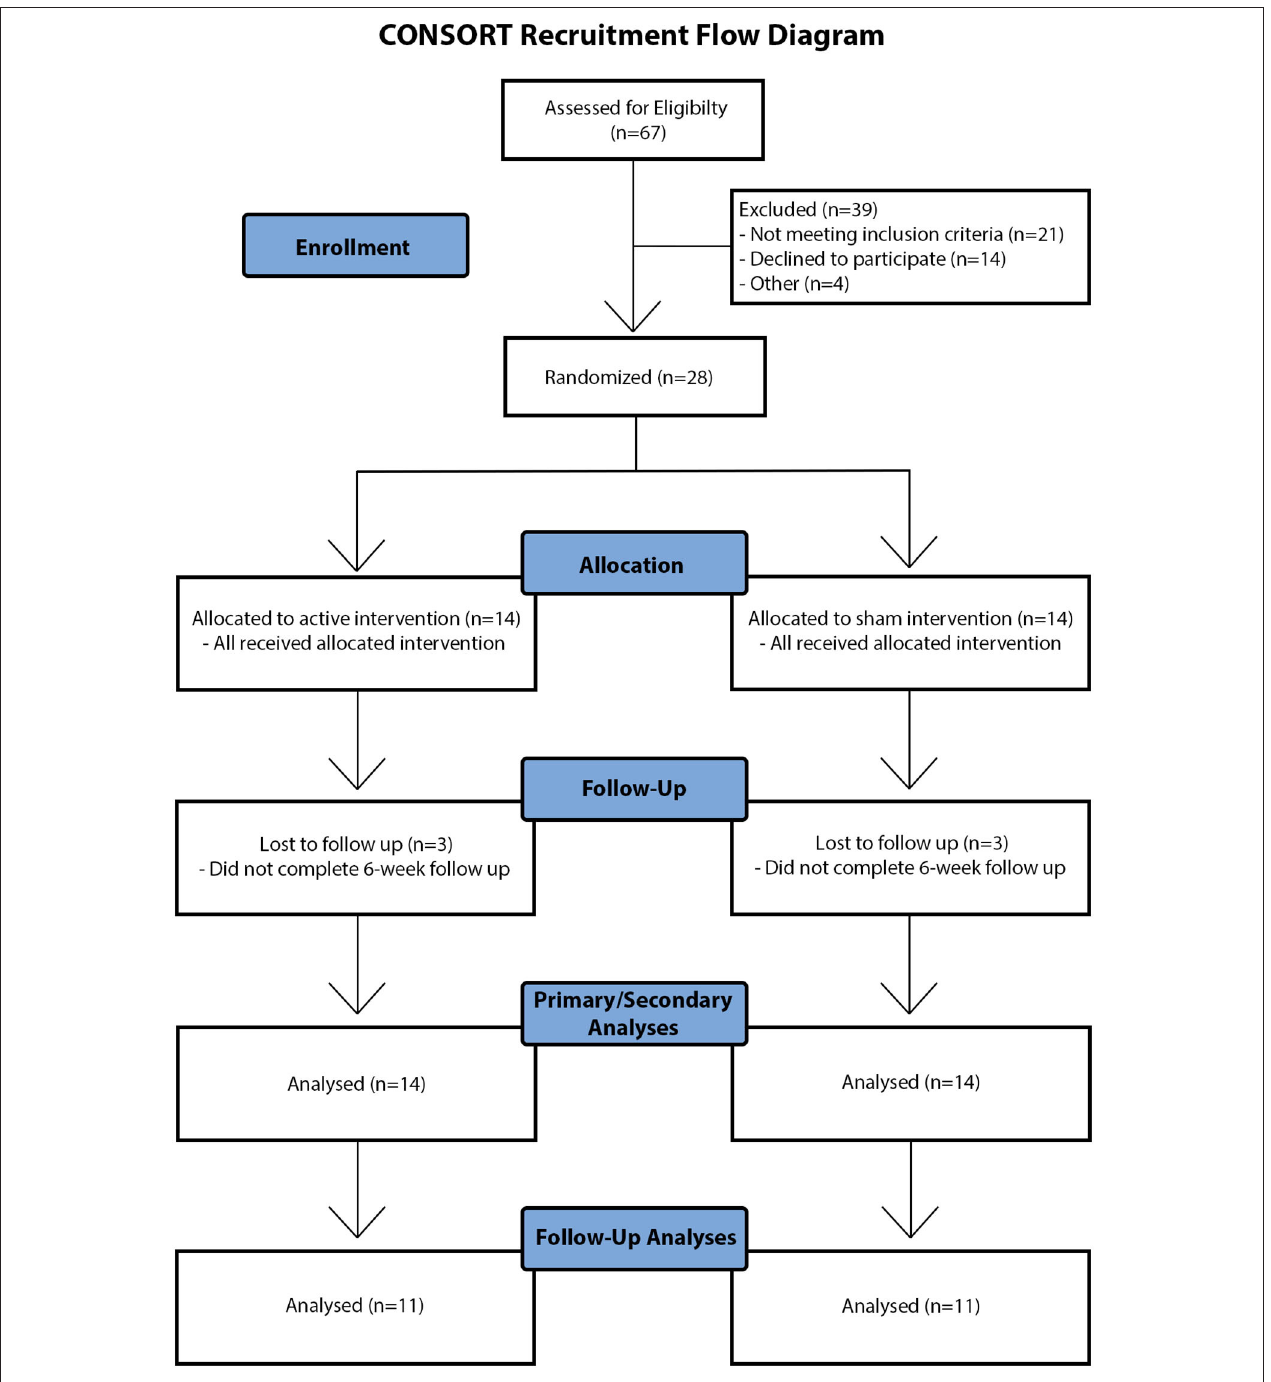
FIGURE 2 | CONSORT recruitment flow diagram. Visual schematic of participant recruitment, screening, data collection, and analysis. Note that “other reasons” for exclusion of children at eligibility screening and follow-up included travel and family factors.